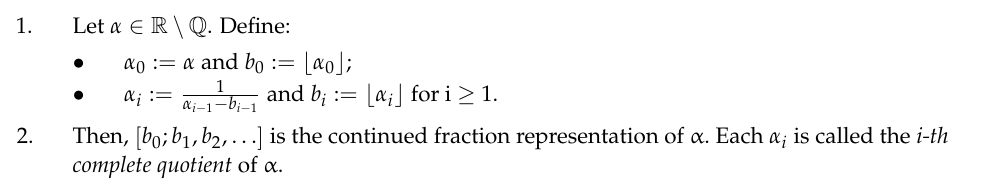
Algorithm 1 Continued Fraction Representation of Non-Rational